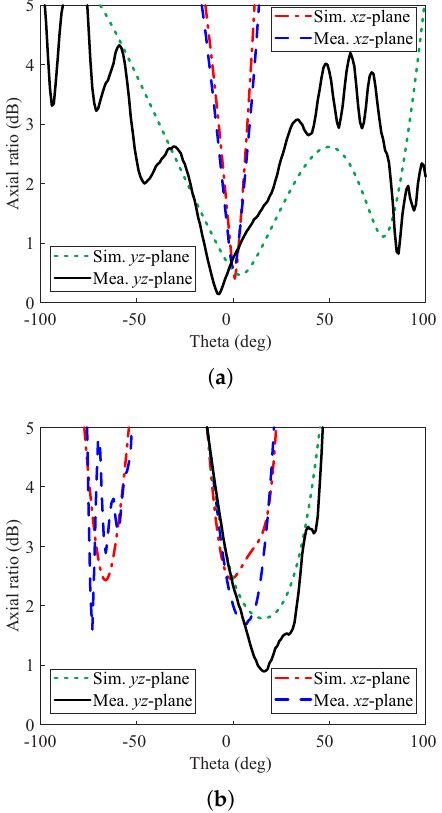
Figure 11. Simulated and measured axial ratios versus theta of the proposed DRA: ( a ) 2.46 GHz; ( b ) 3.5